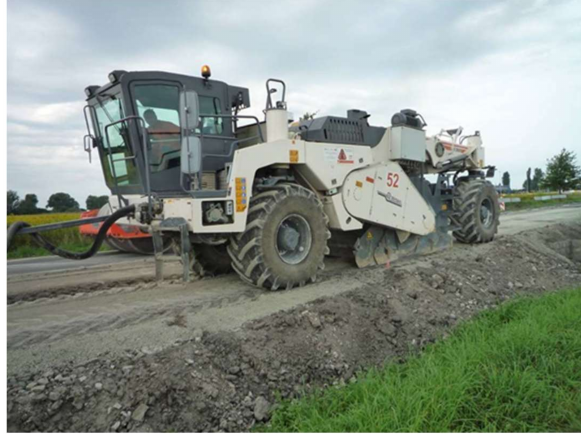
Figure 9. Recycling on-site—crushing and mixing of